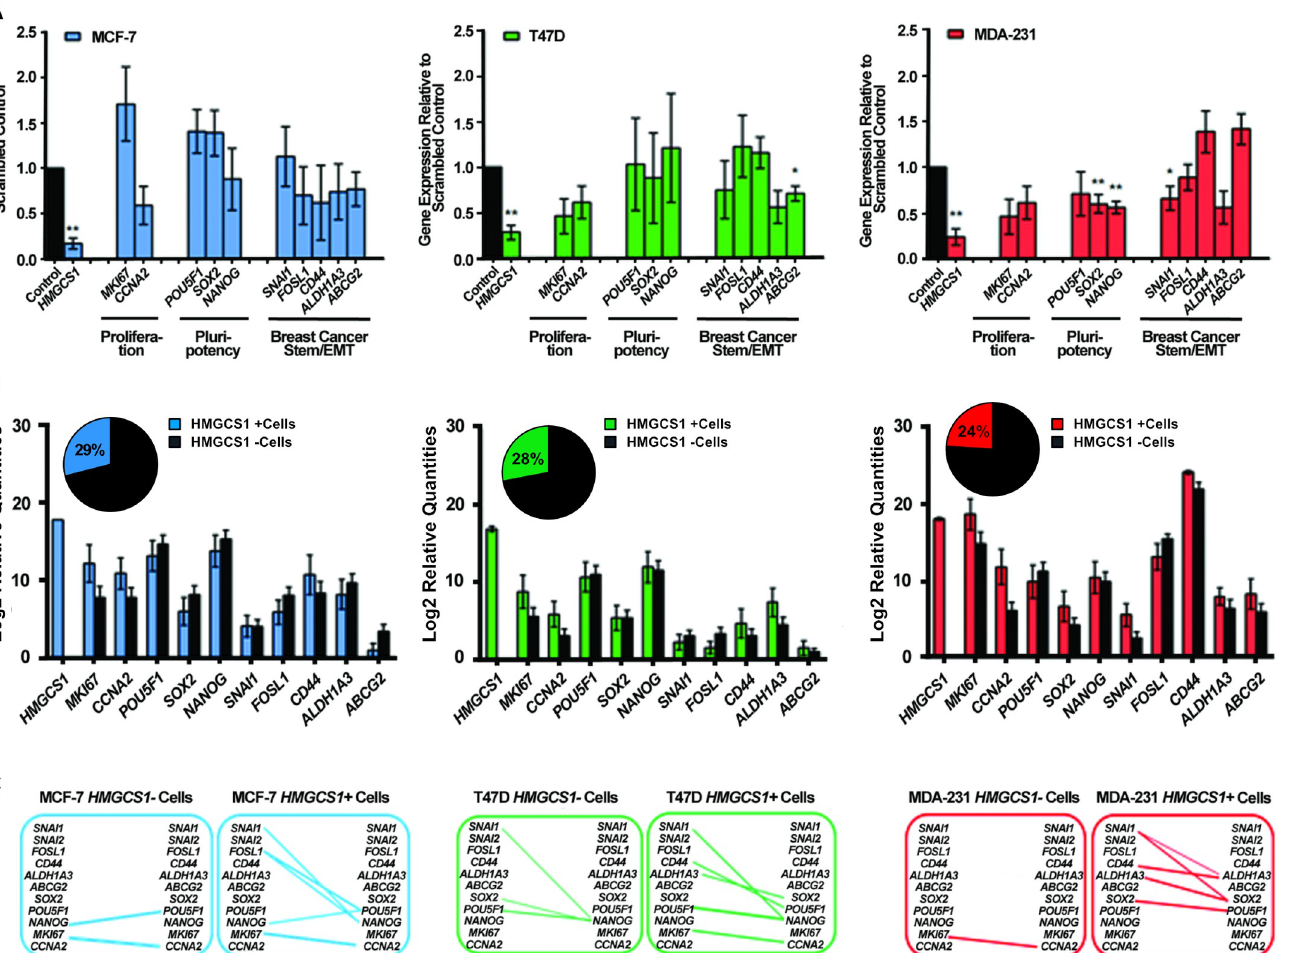
Fig 3. Silencing of HMGCS1 gene expression reduced the expression of CSC-associated genes in the basal model of breast cancer. A. RT-qPCR analysis of the transcript levels of proliferation, pluripotency and EMT/stem-like related genes for MCF-7, T47D and MDA-MB-231 (MDA-231) cells transfected with either scrambled negative control or HMGCS1 siRNA. Expression levels for each individual gene were normalized to the scrambled negative control for each cell line. Graphs show mean ± SEM, n = 3, � p < 0.05, �� p < 0.01 by two-tailed paired Student’s t-test. B. Single-cell gene expression profiling in single cells expressing HMGCS1 (blue, green, red) versus cells which do not express HMGCS1 (black), of adherent monolayer cultures for MCF-7 (blue, n = 76), T47D (green, n = 88) and MDA-MB-231 (red, n = 83) cell lines. Mean ± SEM is shown. The Mann-Whitney U test was used to analyse expression of individual genes between two groups and obtained p-values were Bonferroni-adjusted to correct for multiple testing (S6 Table). C. Spearman’s correlation analysis was conducted on single-cell populations which did not express HMGCS1 (MCF-7, n = 54; T47D, n = 63; and MDA-MB-231, n = 62) or expressed HMGCS1 (MCF-7, n = 22; T47D, n = 25; and MDA-MB- 231, n = 21), respectively. Correlations were drawn between the same proliferation, pluripotency and EMT/stem-like genes as analysed in A (S7–S9 Tables). Connecting lines were weighted in an increasing manner to represent increasing correlation coefficient values (p < 0.05, ρ �